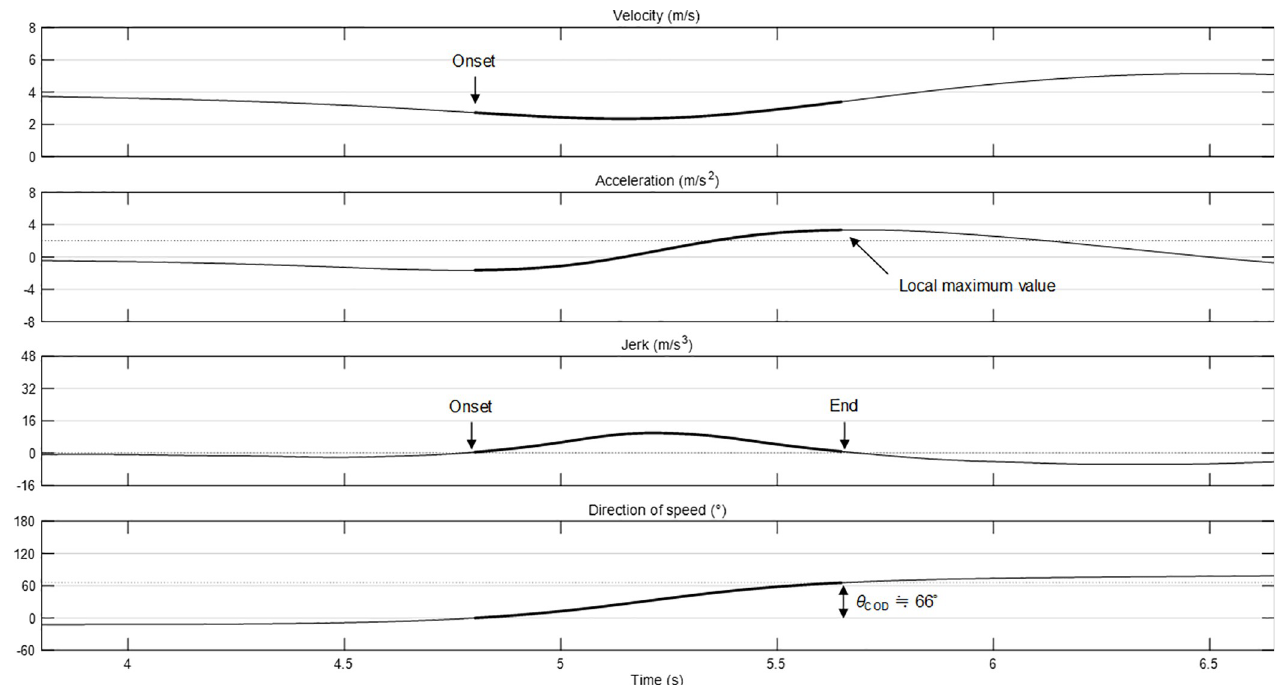
Fig 1. Analysis method for θ COD . Dotted line in line plot of acceleration indicates a threshold of acceleration (2 m/s 2 ).